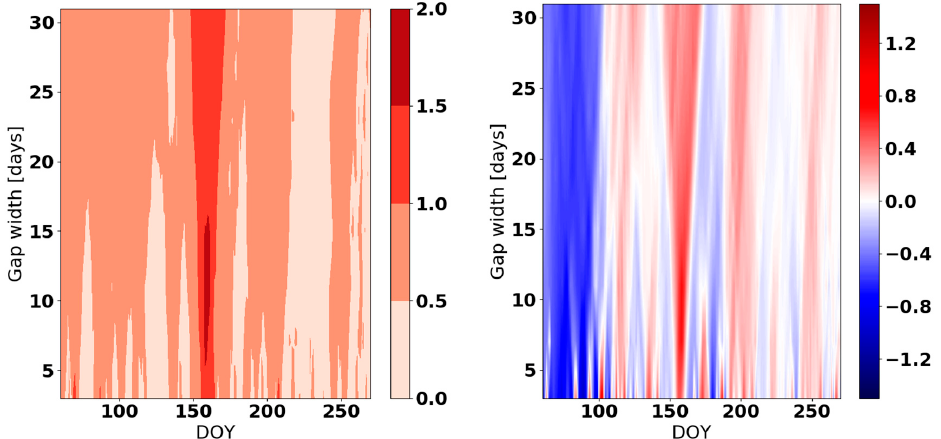
Figure A6. RMSE DEB (left panel ) and (RMSE DEB -RMSE ERA5 ) difference ( right panel ) calculated using daily data for DOY 60-273 2014 in Kikinda.